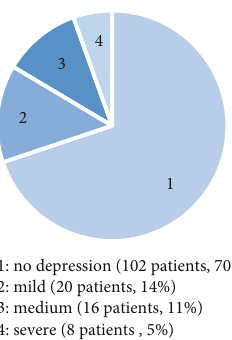
Figure 1: Depression type according to the BDI-II